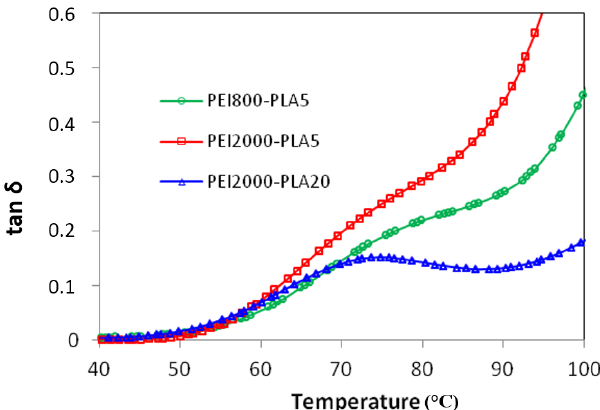
Figure 10. Dielectric relaxation spectroscopy curves for the β -relaxation for the different samples studied: PEI2000-PLA5, PEI2000-PLA20 and PEI800-PLA5. Frequency: 100 kHz. Heating rate: 0.5 °C/min.